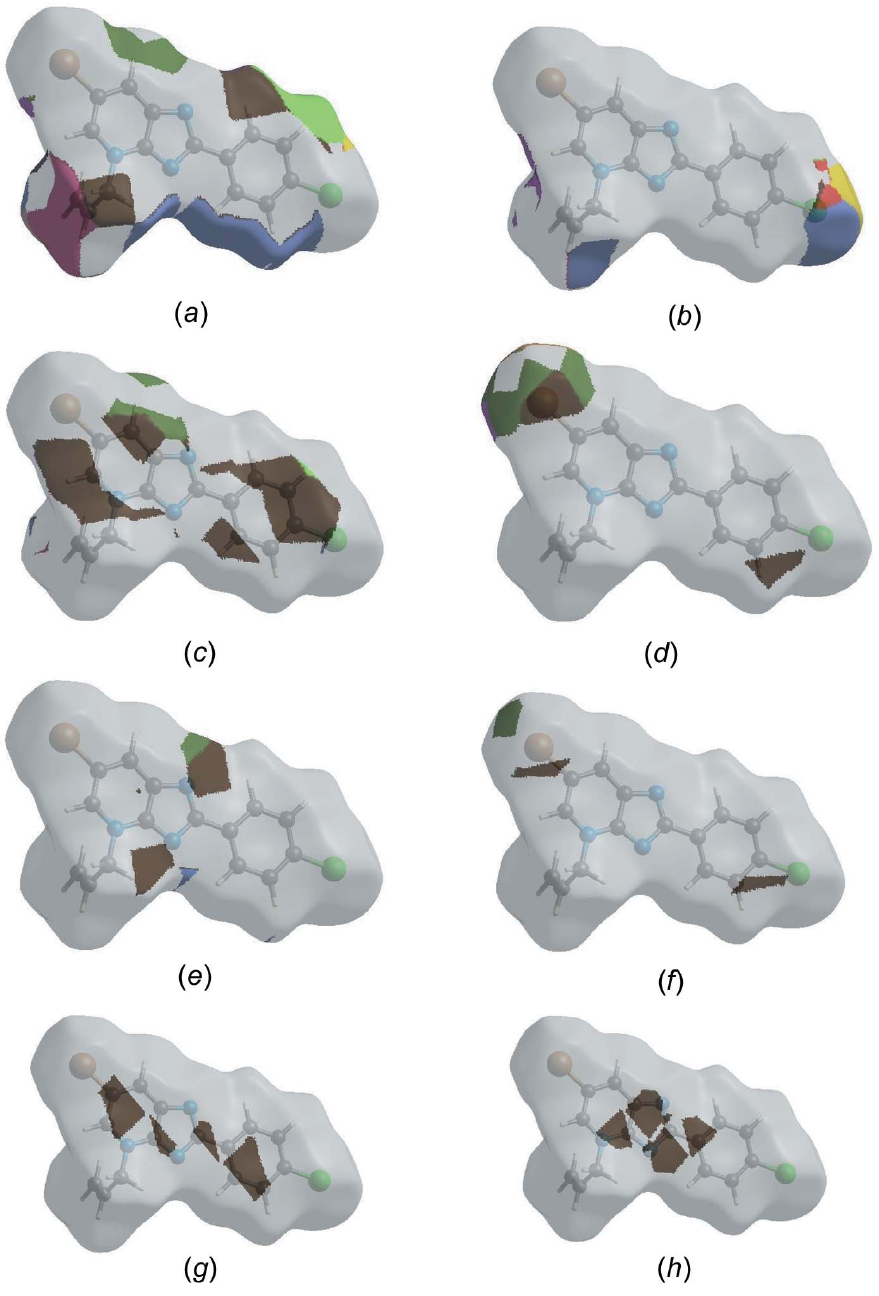
Figure 6 The Hirshfeld surface representations with the function d norm plotted onto the surface for ( a ) H (cid:3)(cid:3)(cid:3) H, ( b ) H (cid:3)(cid:3)(cid:3) Cl/Cl (cid:3)(cid:3)(cid:3) H, ( c ) H (cid:3)(cid:3)(cid:3) C/C (cid:3)(cid:3)(cid:3) H, ( d ) H (cid:3)(cid:3)(cid:3) Br/ Br (cid:3)(cid:3)(cid:3) H, ( e ) H (cid:3)(cid:3)(cid:3) N/N (cid:3)(cid:3)(cid:3) H, ( f ) C (cid:3)(cid:3)(cid:3) Br/Br (cid:3)(cid:3)(cid:3) C, ( g ) C (cid:3)(cid:3)(cid:3) C and ( h ) C (cid:3)(cid:3)(cid:3) N/N (cid:3)(cid:3)(cid:3) C